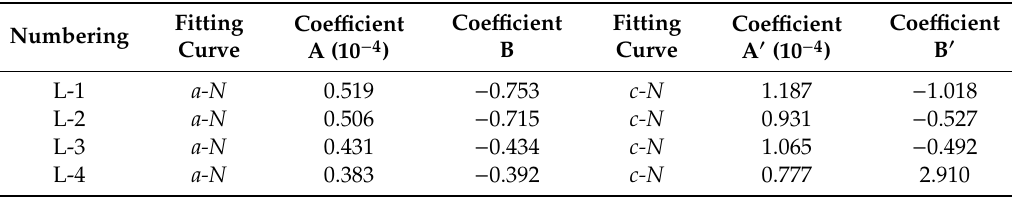
Figure 23. Variation of crack width with cyclic numbers.